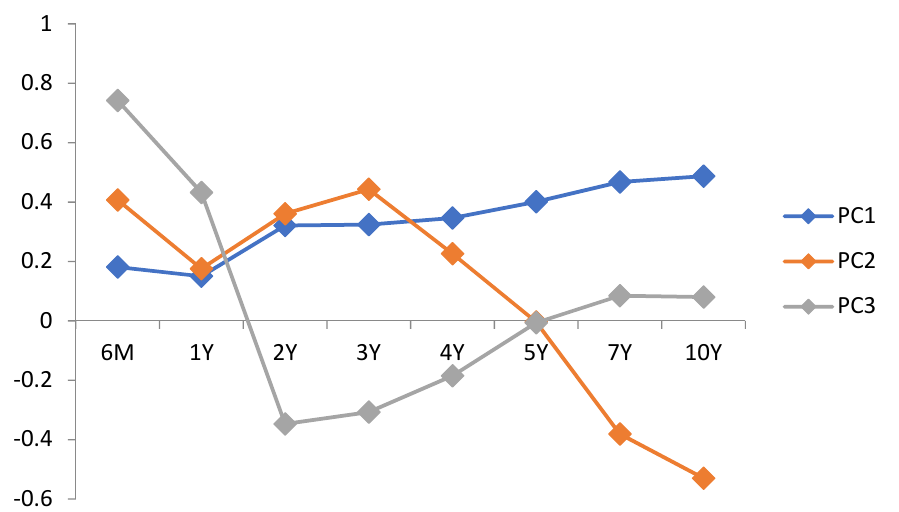
Figure 4. Factor loadings of the first three principal components on 25 March 2022. Source: Bloomberg, own computation of PCs with the use of a VBA add-in developed by Leonardo Volpi.